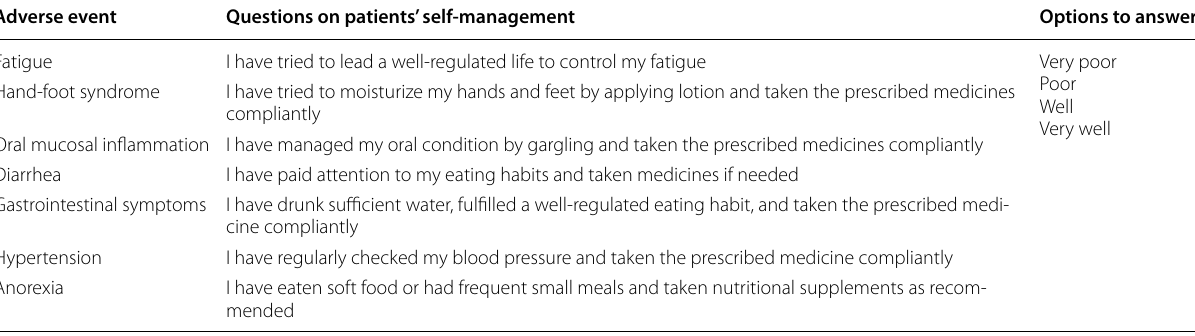
a The patient survey of AEs was produced in paper format. The form was horizontally long and folded into sections divided for each visit. Patients were able to write the content of their current (next) visit whilst referring to their previous responses on the survey form